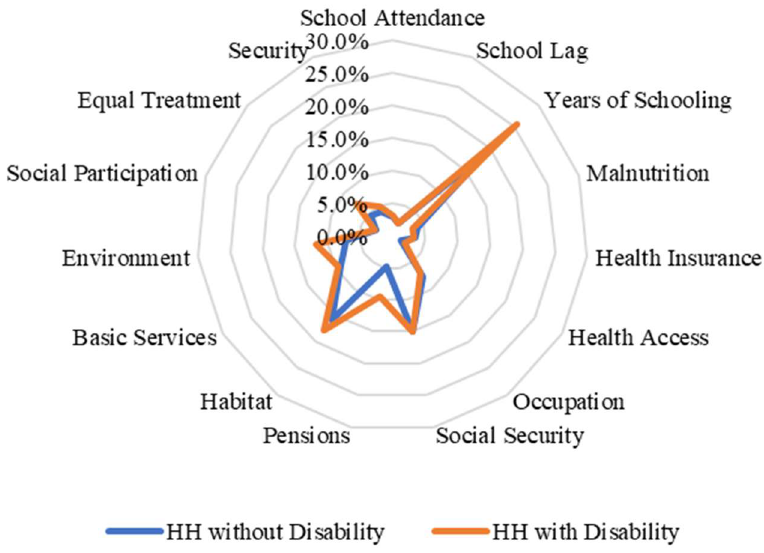
Figure 2. Censored headcount ratios for households with and without members with disability in the lowest quintile in Chile.